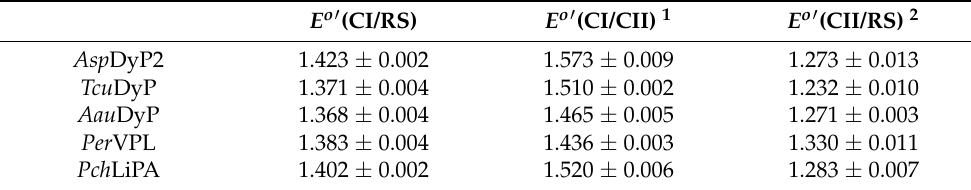
Table 3. E o (cid:48) values (in V) of the CI/RS, CI/CII and CII/RS couples, estimated from stopped-flow experiments, in bacterial Asp DyP2 and Tcu DyP, and fungal Asp DyP2, Per VPL and Pch LiPA. E o (cid:48)